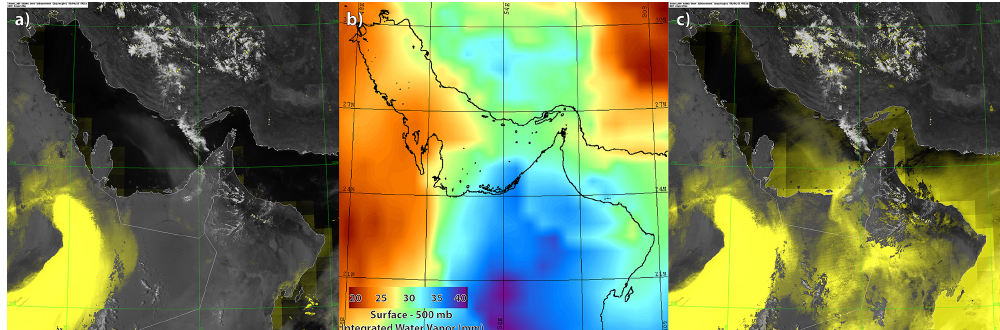
Figure 14. (a) Original DEBRA (Fig. 4a) dust enhancement, (b) NUCAPS surface-to-500hPa IWV (via Fig. 9a) used as an index to modulate the SWBTD, and (c) the revised DEBRA dust enhancement with IWV-modulated SWBTD thresholds applied, capturing significant portions of the missing dust plume both on- and